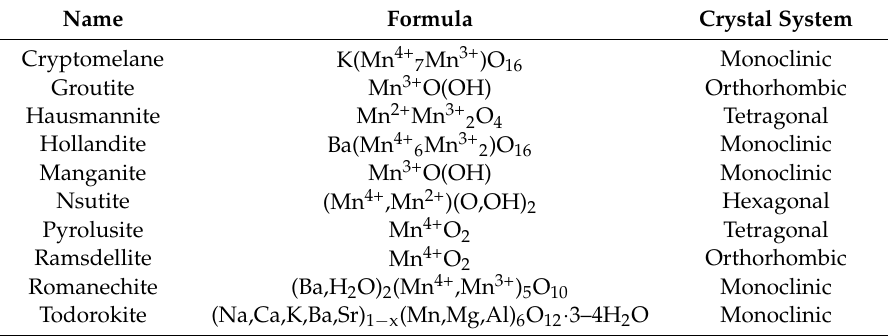
Table 1. Manganese oxide and oxide hydroxide minerals encountered in